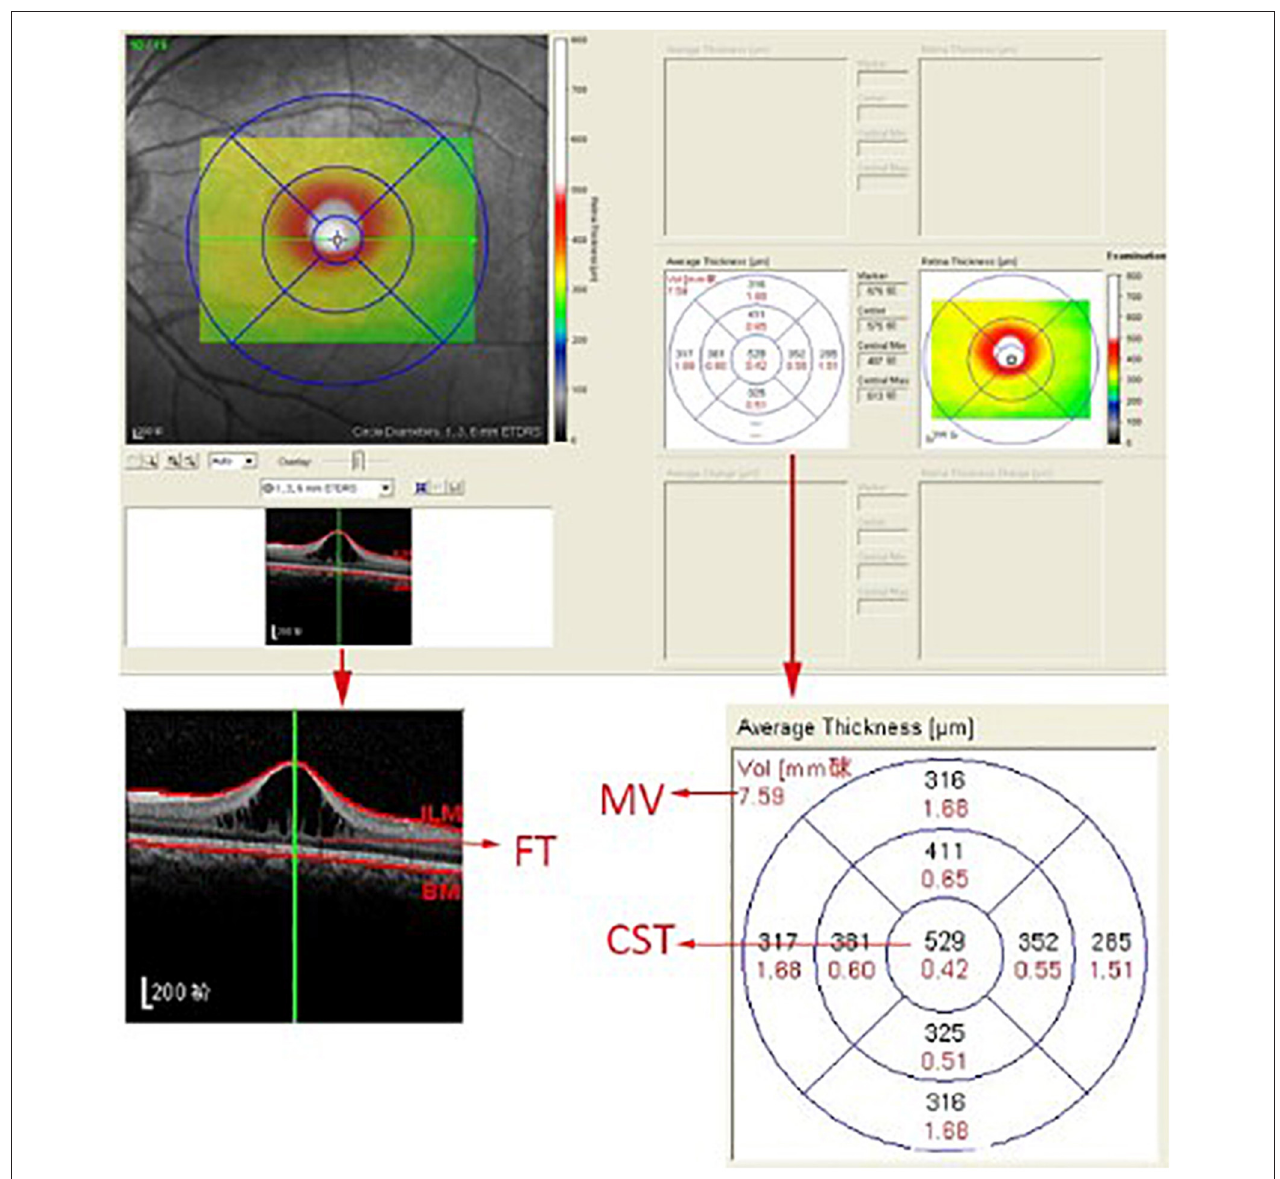
FIGURE 1 | The computer user interface of the spectral-domain optical coherence tomography. The foveal thickness (FT), central subfield thickness (CST), and macular volume (MV) were automatically measured by the built-in software of the spectral-domain optical coherence tomography device.